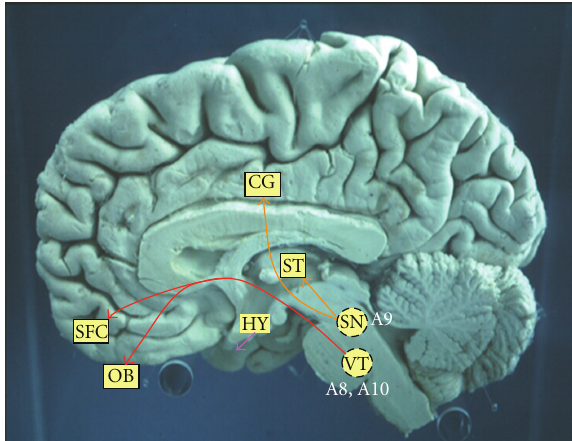
Figure 3: The dopamine projections of the central nervous system (OB: Olfactory bulb, SFC: superior frontal cortex, CG: Cingulate gyrus, ST: Striatum, HY: Hypothalamus, VT: Ventral tegmentum, SN: Substantia